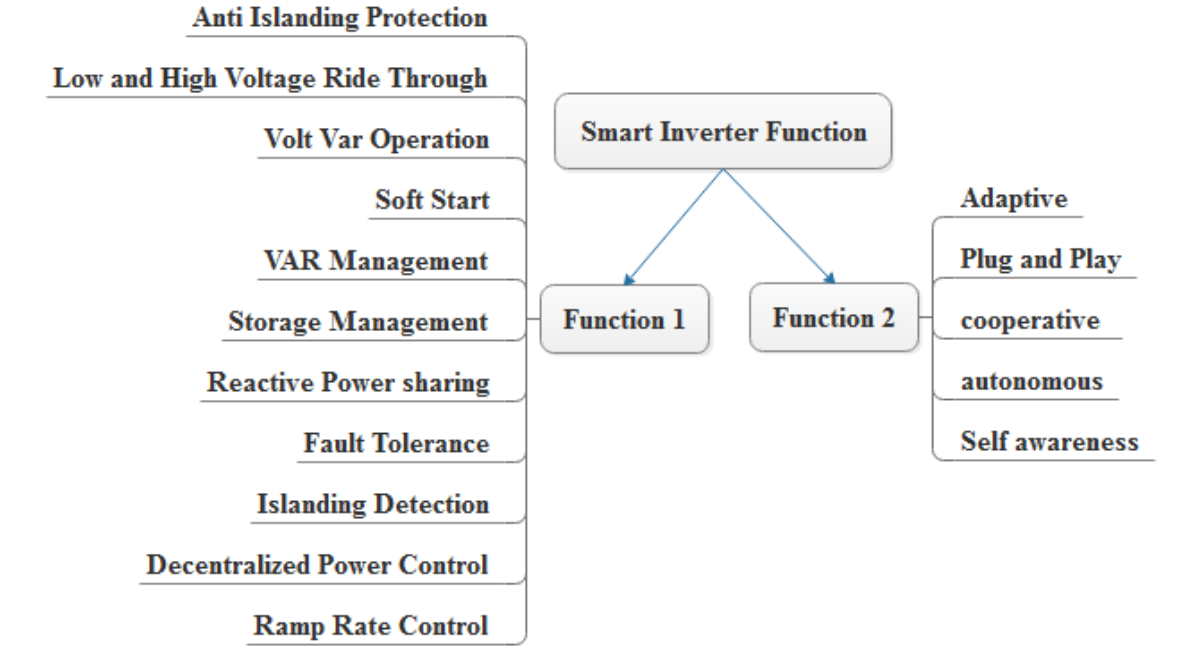
Figure 40. Smart inverter functions.